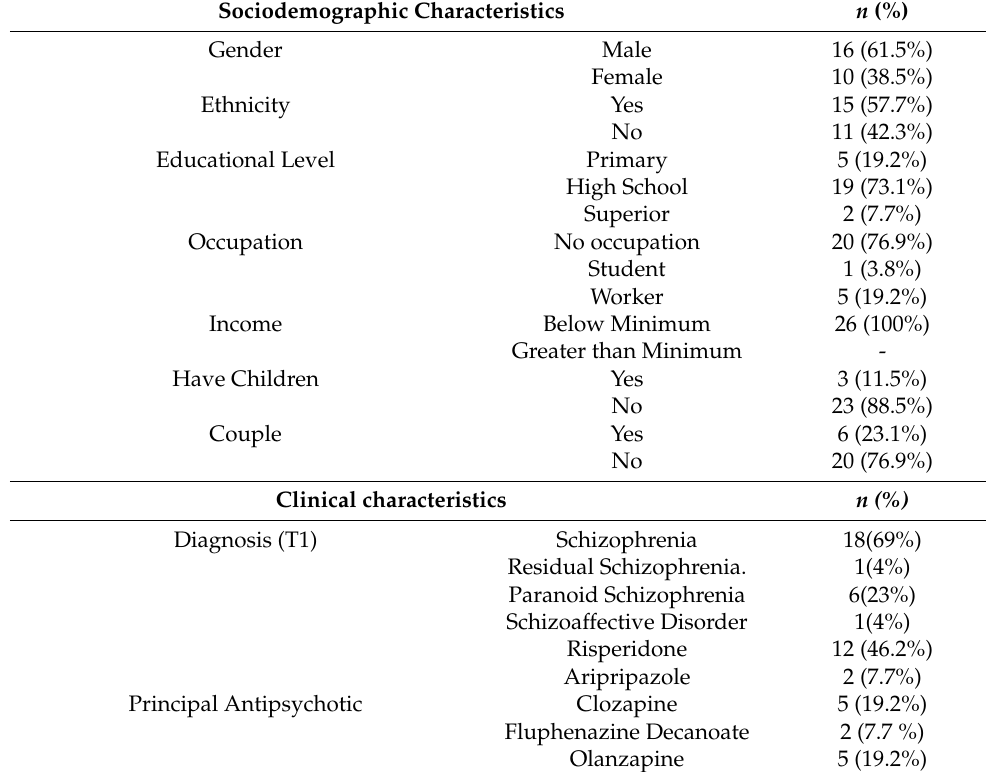
Table 1. Clinical and Sociodemographic